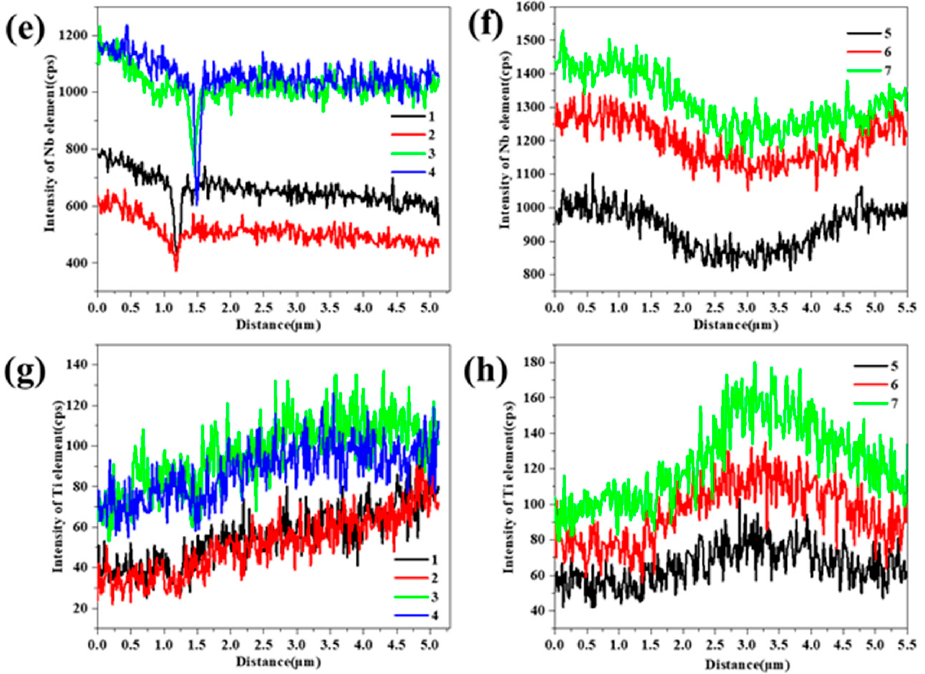
Figure 13. SEM micrograph of a U-groove with greater depth to diameter ratio ( a ) and the relevant SEM-EDS line scanning in it ( b ), the relative content of Al, Nb and Ti along the dot line marked in ( b ) by SEM-EDS line scanning: ( c , d ) for Al, ( e ) and ( f ) for Nb, ( g ) and ( h ) for Ti.